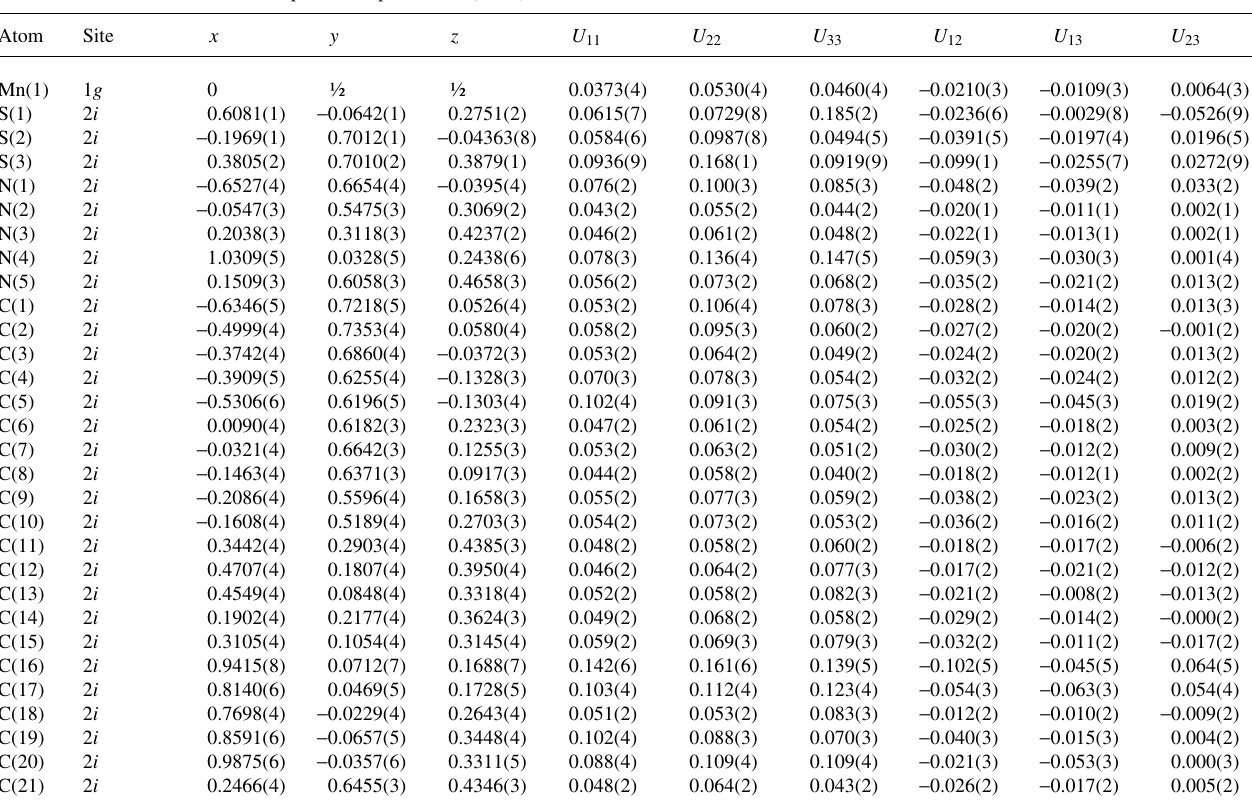
Table 3. Atomic coordinates and displacement parameters (in Å 2 ) .